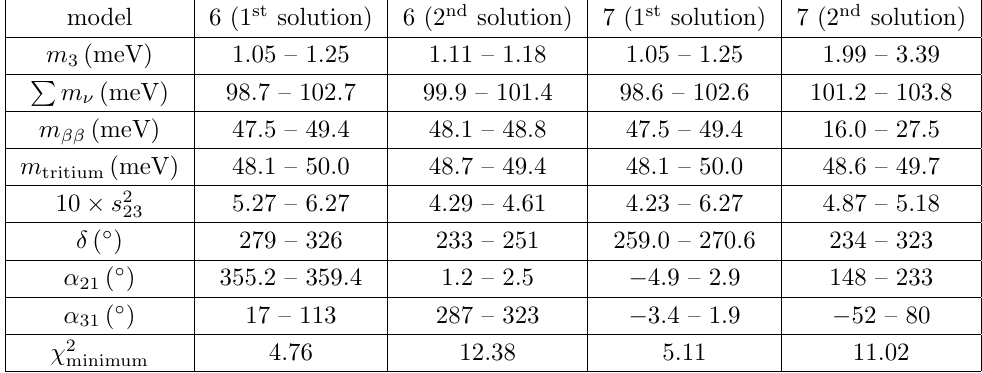
Table 2 . The 3 (cid:27) bounds for various observables in the models with inverted neutrino mass ordering. These bounds correspond to (cid:31) 2 (cid:0) (cid:31) 2 by the NuFIT collaboration, in the computation of (cid:31) 2 than the corresponding values for models with NO in table